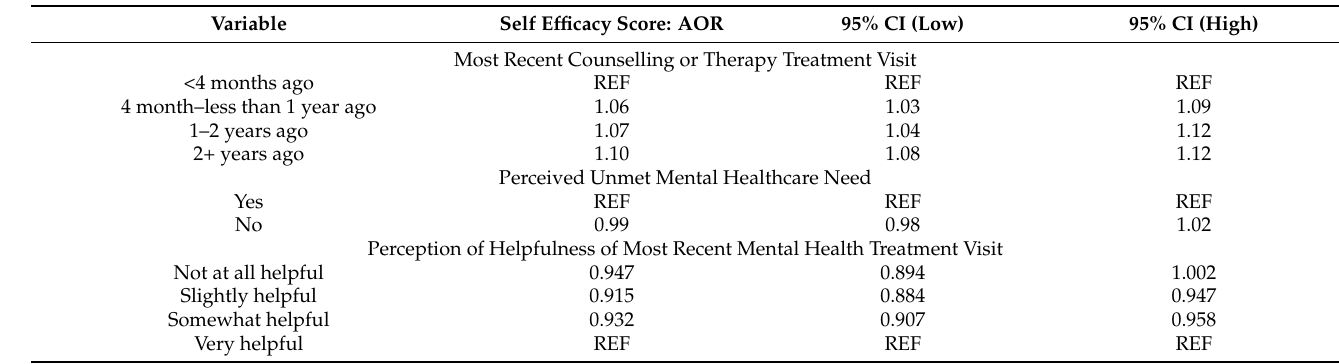
Table 4. Adjusted Odds Ratios (AORs) of Outcomes 1–3 (1. Most recent counselling or therapy